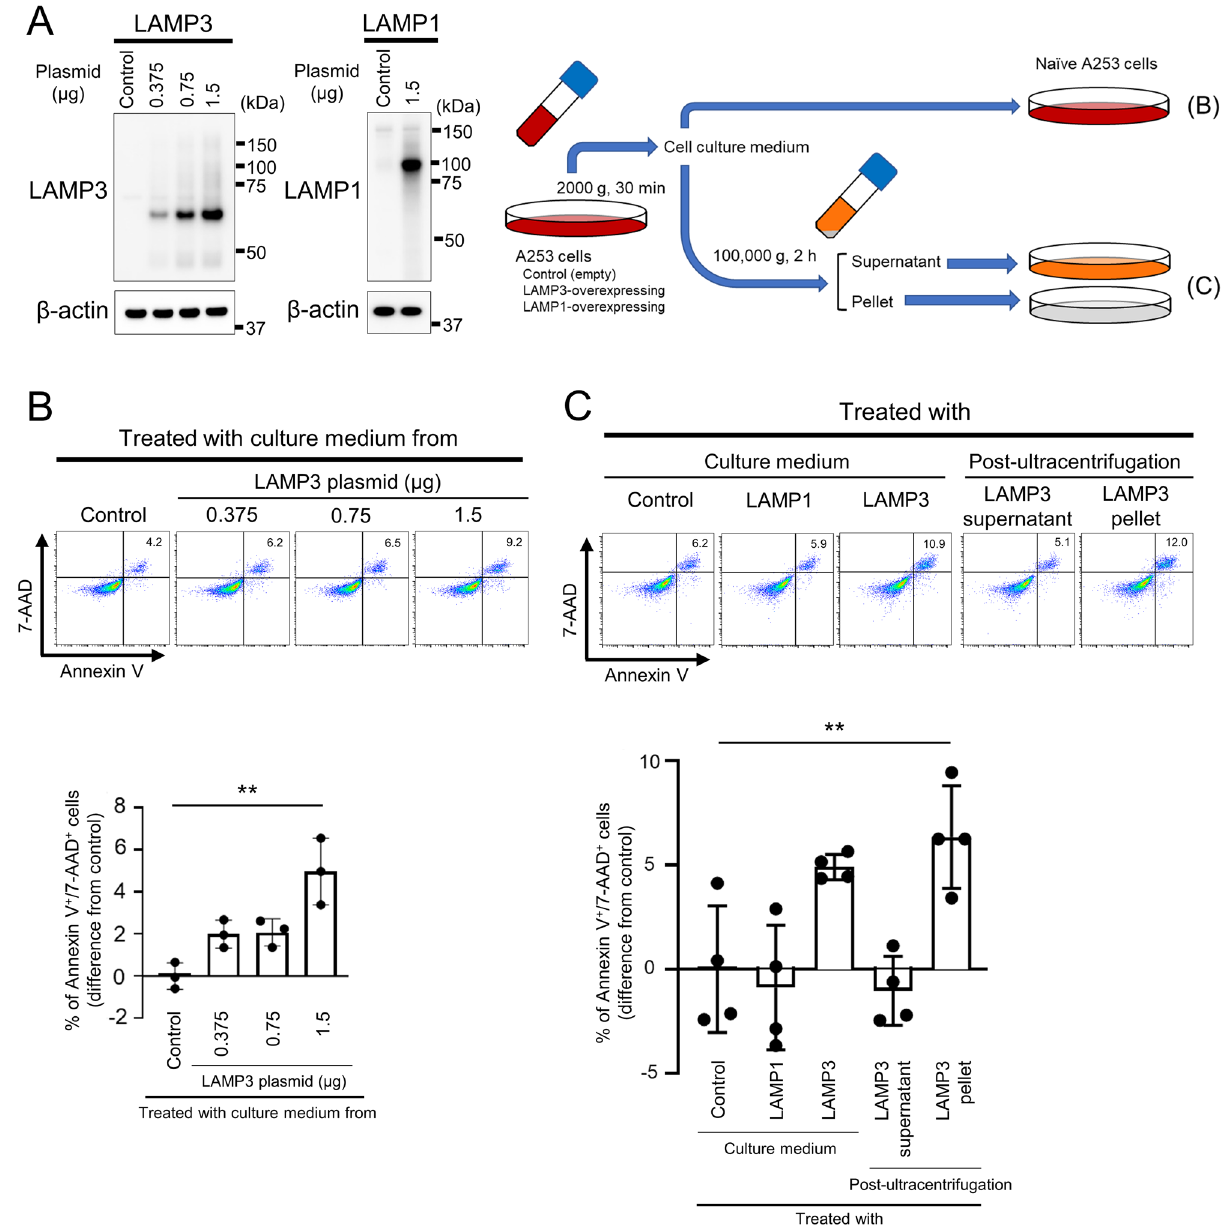
Figure 2. Culture medium of LAMP3-overexpressing A253 cells induce apoptosis in naïve A253 cells. A253 cells were transfected with control empty plasmid, LAMP3 -encoding plasmid or LAMP1 -encoding plasmid. ( A ) Representative Western blots of transfected A253 cells (uncropped images are provided in Supplementary Fig. 3) and schematic methods of the following in vitro assays. ( B ) Naïve A253 cells were treated with culture medium of control or LAMP3-overexpressing A253 cells for 48 h ( n = 3). ( C ) Naïve A253 cells were treated with culture medium of control, LAMP1-overexpressing, or LAMP3-overexpressing A253 cells or with post- ultracentrifugation supernatant or post-ultracentrifugation pellet from LAMP3-overexpressing A253 cells for 48 h ( n = 4). Apoptotic cells in naïve cell culture were determined by flow cytometry using APC Annexin V/7- AAD. Graphs show difference in mean (± SD) number of Annexin V + /7-AAD + cells in cell culture compared with control. ** p < 0.01 (one-way